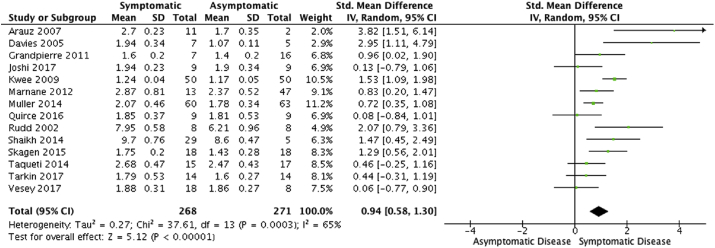
Forest plot for analysis of 18F-FDG uptake in symptomatic versus asymptomatic carotid disease (p < .00001).